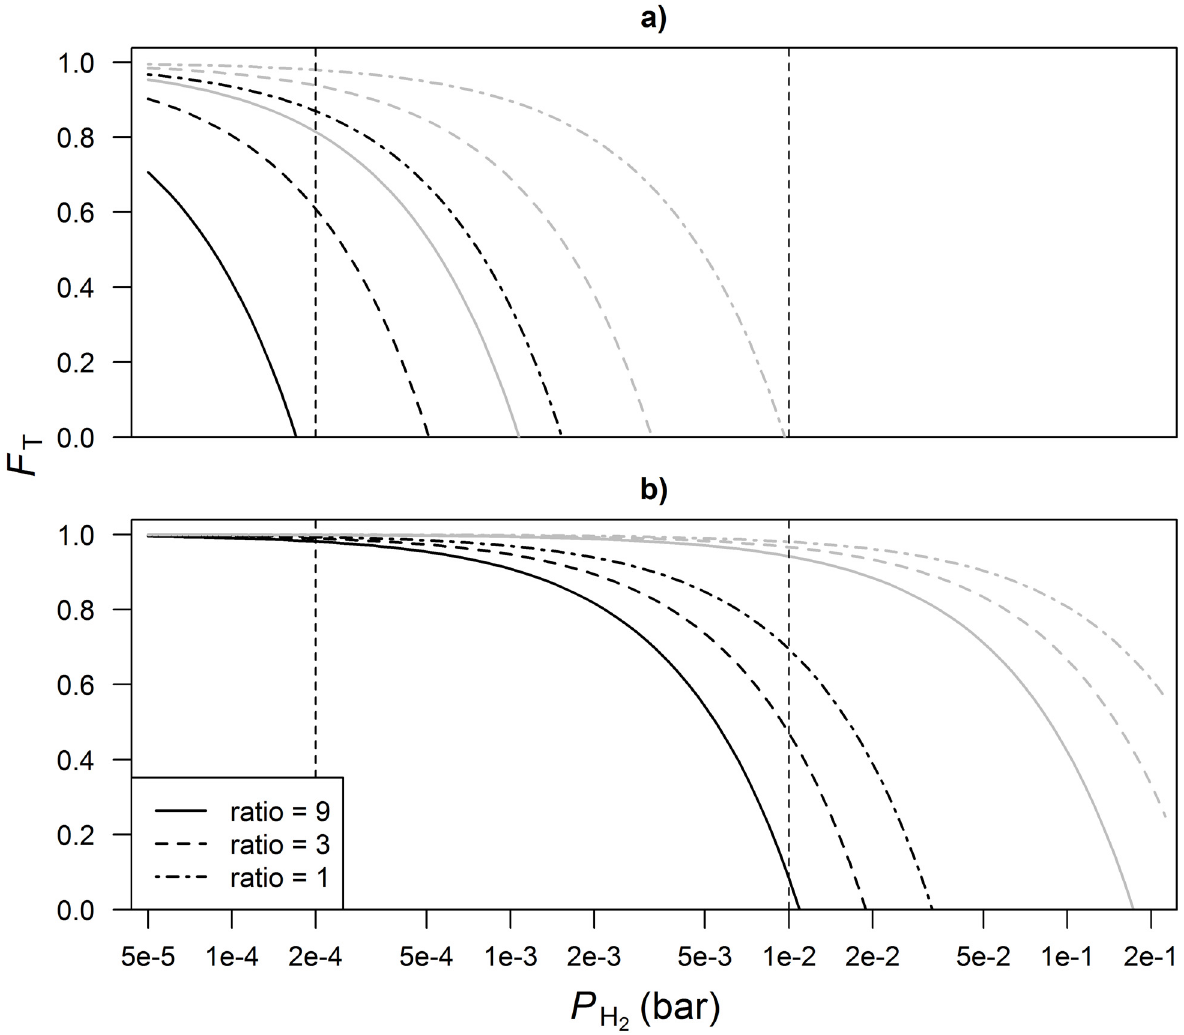
Fig 2. Thermodynamic potential factor ( F T ) as a function of P H oxidation with ferredoxin oxidation and the Fd RED2- to Fd OX ratio constant at 9. Line type represents NAD + to NADH ratio and line color represents intracellular pH equal to 6.2 (gray) and 7.0 (black). Vertical lines demarcate the rumen physiological range of P H scale is used to plot the